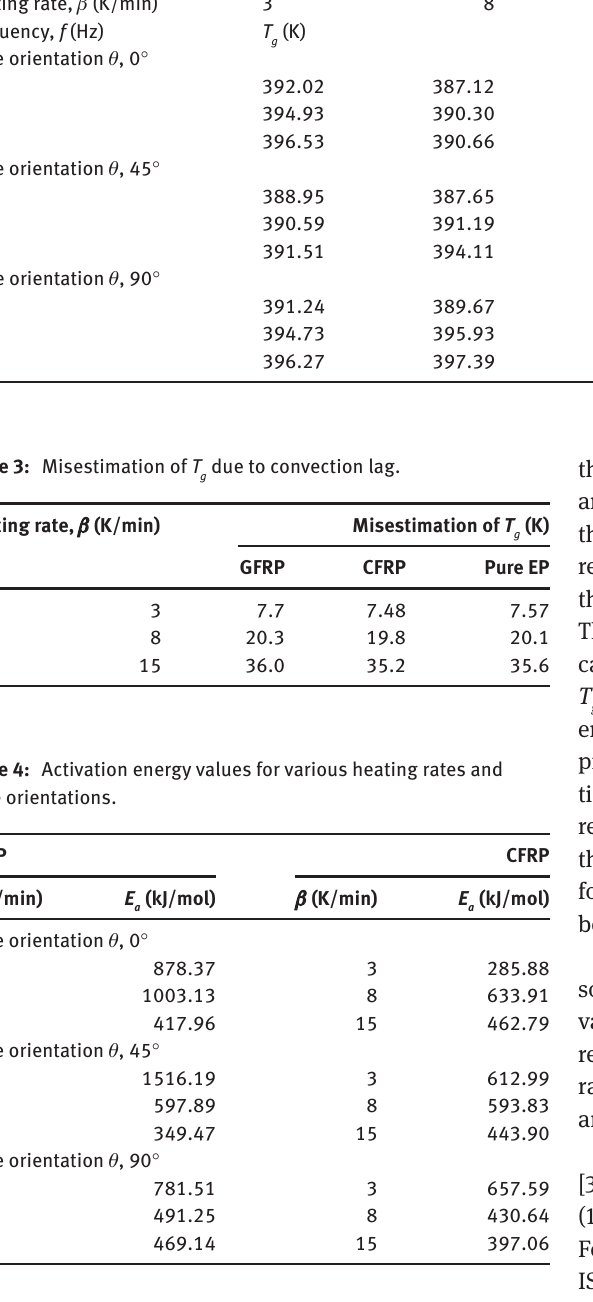
for various frequencies, heating rates and fibre orientations considering convection. Table 2: Values of T g